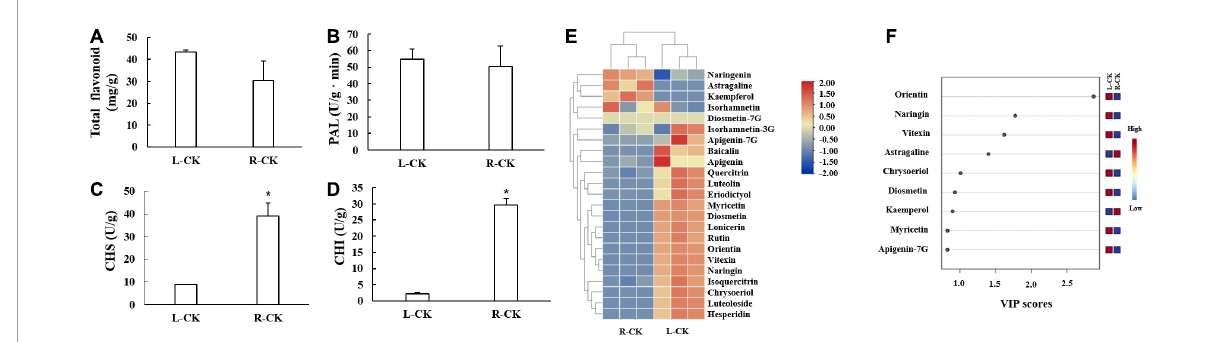
FIGURE1 Flavonoid contents and flavonoid synthesis related enzymes activities in control group of Tetrastigma hemsleyanum . (A) Total flavonoids. (B) Phenylalanine ammonia-lyase (PAL). (C) Chalcone synthase (CHS). (D) Chalcone isomerase (CHI). (E) Heatmap of flavonoid metabolites. (F) VIP scores. Metabolites with VIP scores higher than 1.0 were obtained through PLS-DA. * P < 0.05.